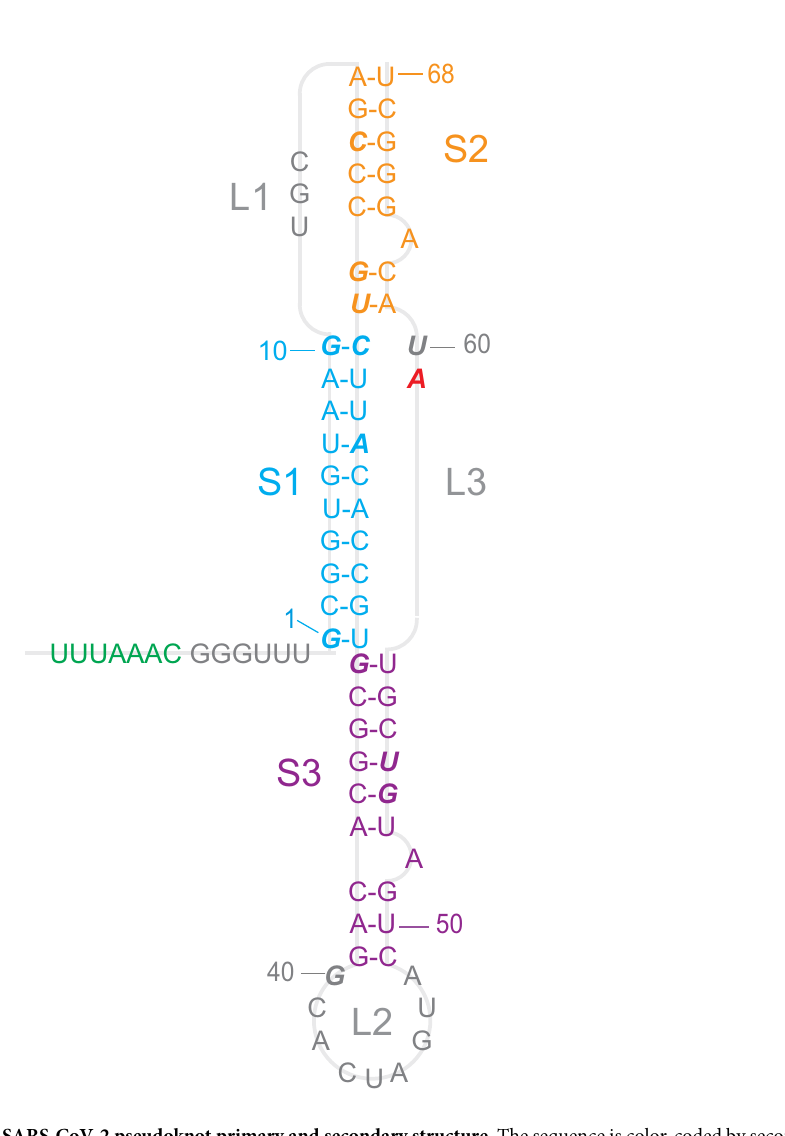
Fig 1. SARS-CoV-2 pseudoknot primary and secondary structure. The sequence is color-coded by secondary structure (S1: cyan, S2: orange, S3: purple, loops: grey). The only difference from SARS-CoV-1 is that A59 (red) is changed from C59 in the latter. Bases shown in italic are protected against nuclease digestion in SARS-CoV-1. Slippery sequence shown in green.